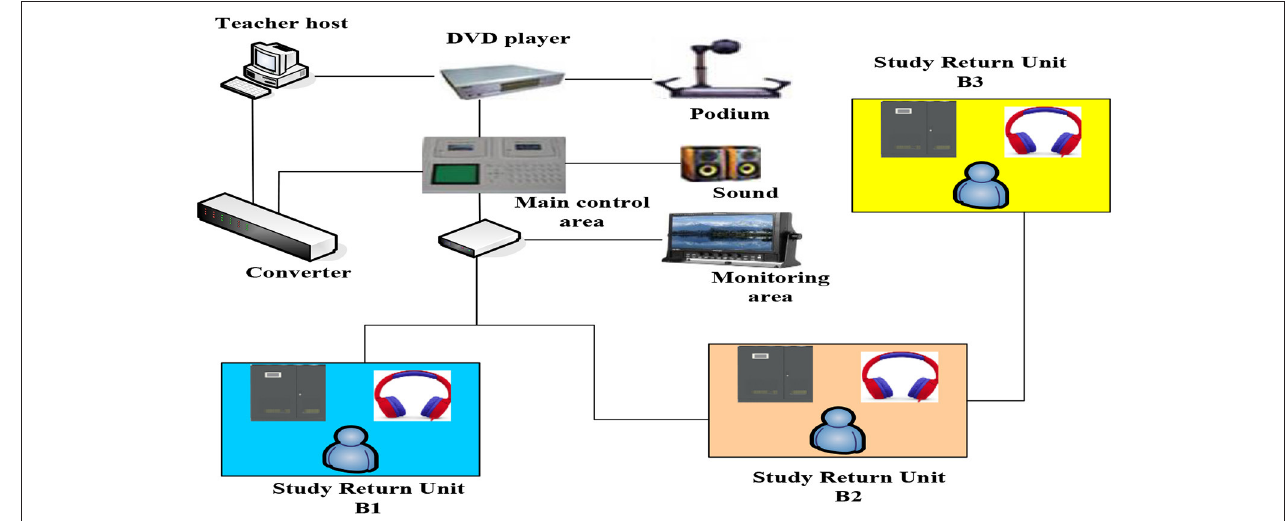
FIGURE 3 | The English competitive learning